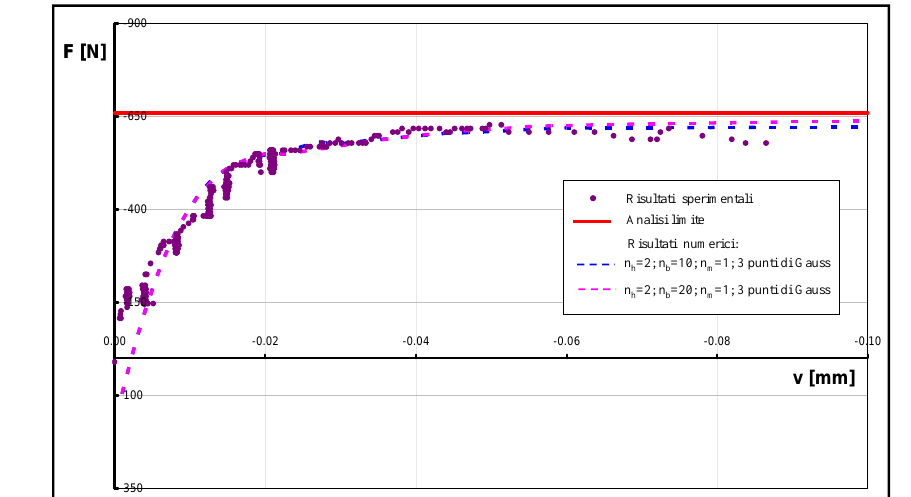
Figura 15: Risultati del secondo gruppo di